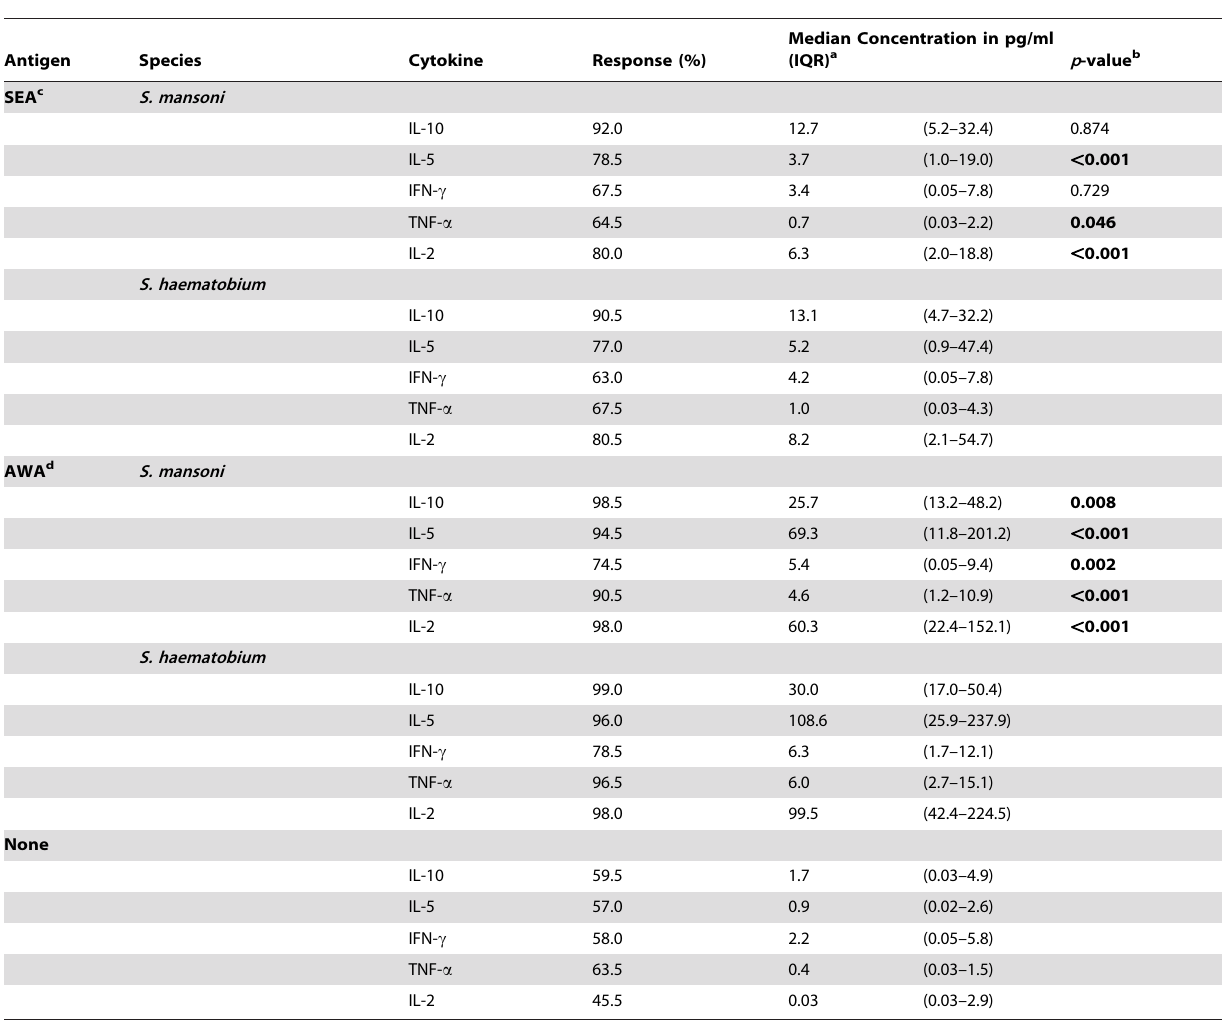
Table 3. Levels of Schistosoma -induced cytokine responses in 72 h whole blood cultures (n=200).